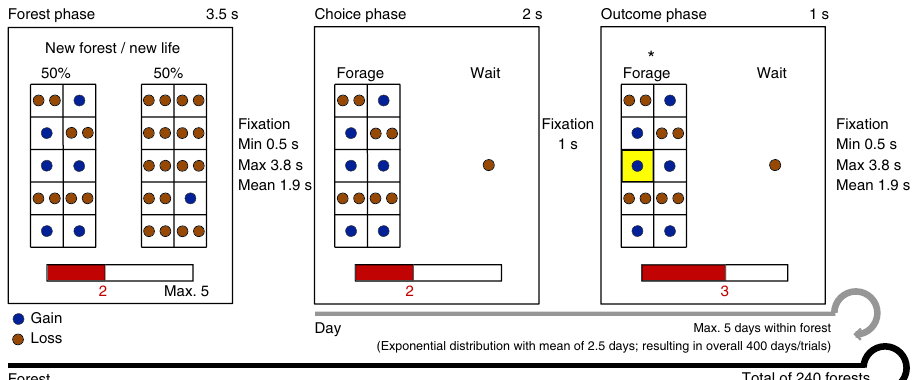
Fig. 1 Sequential decision-making task in a virtual foraging frame. Participants “ forage ” within 240 different types of mini-blocks, called “ forests ” . They are monetarily rewarded for averting “ starvation ” (keeping “ energy bar ” above zero) at day fi ve in the forest (i.e., the last trial within a mini-block). The initial energy is reset in new forests. In the forest phase, participants see the two foraging environments or “ weather types, ” that de fi ne the forest. This information is necessary so that participants can infer all possible future states. No choice is required during the forest phase. In the following time steps, called “ days, ” within a forest, each of the two weather types occurs with a probability of 0.5. We depict foraging environments in the form of spatial grids (to allude to food distribution in natural environments). The numbers of colored dots within a sub fi eld of the grid illustrates the magnitudes of potential gains and losses. If participants choose to forage, each of the 10 sub fi elds of the grid has a 0.1 probability of being realized. Thus, the probability of foraging success is the proportion of sub fi elds containing gains. Here, the probability of foraging success is 0.6 in the left grid and 0.1 in the right grid; and the gain magnitude is 1 point in both. Loss magnitudes are always 2 points. In the example, the left grid depicts “ good ” weather and the right grid “ bad ” weather. In the choice phase of each day, participants decide between foraging and waiting, which entails a sure loss of one energy point. In the outcome phase, participants see the impact of their choice on their energy state. In the depicted example, the participant chose to forage and successfully gained 1 point. The yellow square depicts the realized sub fi eld. After the choice phase and a fi xation period, either a new day in the same forest or a new forest starts. The number of days past in a forest is not shown to participants. See Fig. 2 for mathematical description of the task. See Table 1 and Table 2 for explanations and example parameters according to Fig.